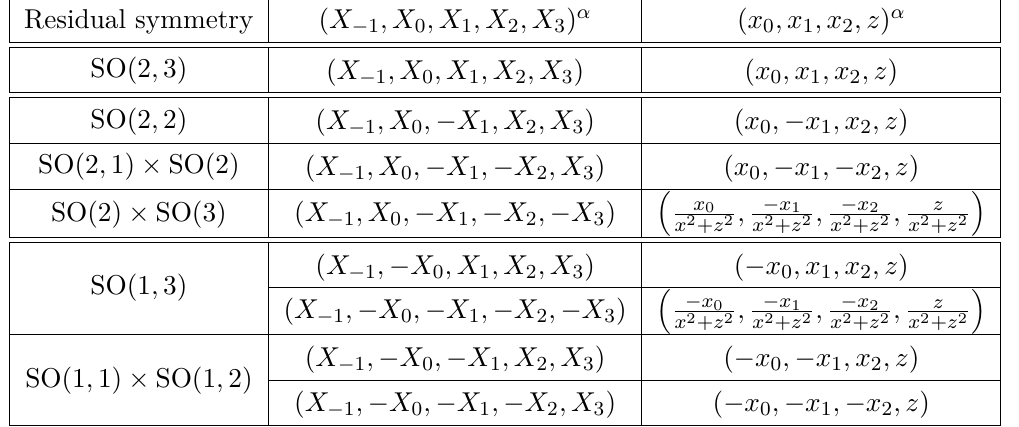
Table 3 . Crosscaps of the sigma model on AdS 4